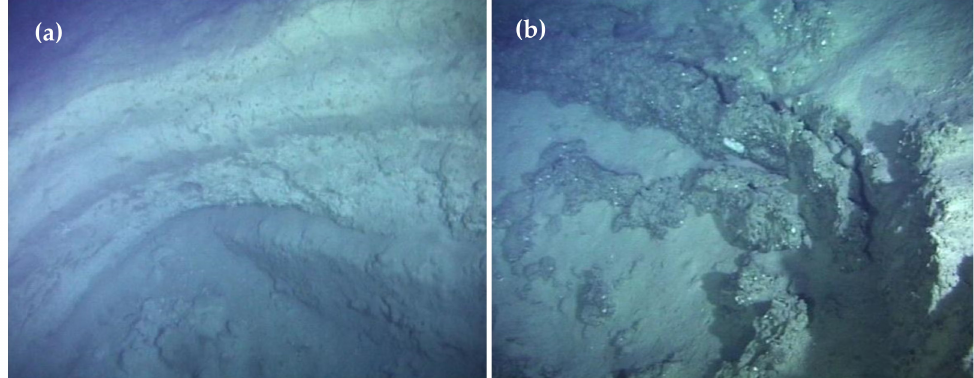
Figure 12. ( a ) Part of the volcanic crater with 8–10 m diameter and height of 4 m, at the western slope of Strongyli volcanic dome (240 m depth) and ( b ) the edge of the volcanic crater with diameter of 4.5 m and height of 2 m at the eastern part of Kondeliousa (430 m depth).